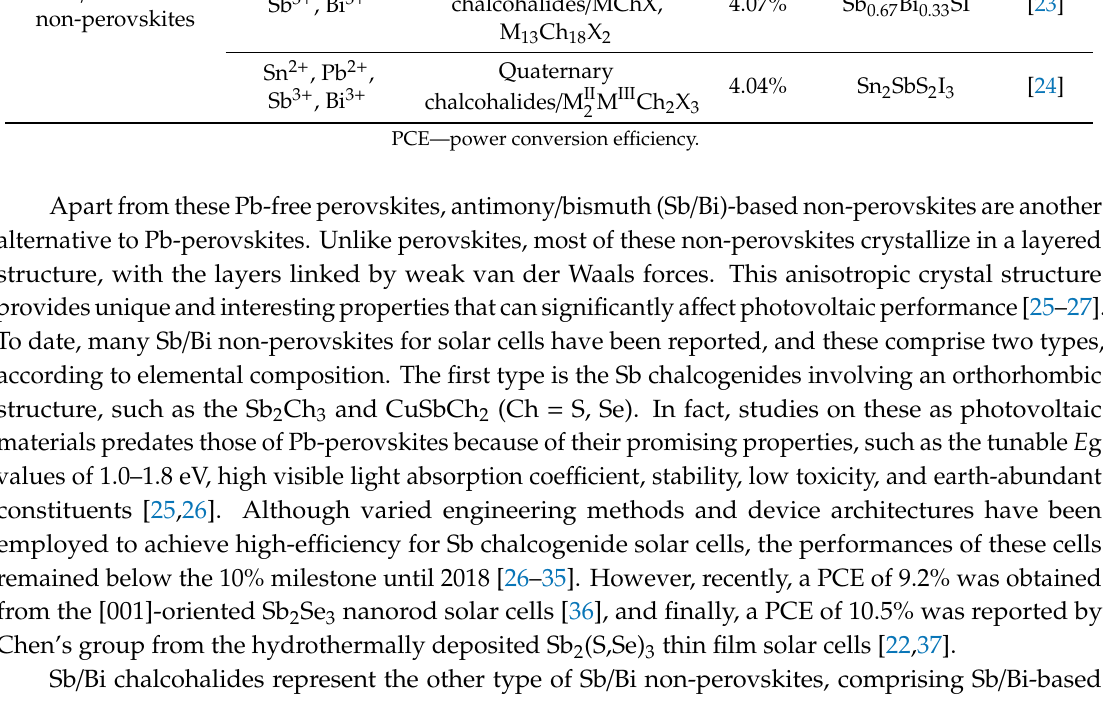
Record Device Performance PCE Material